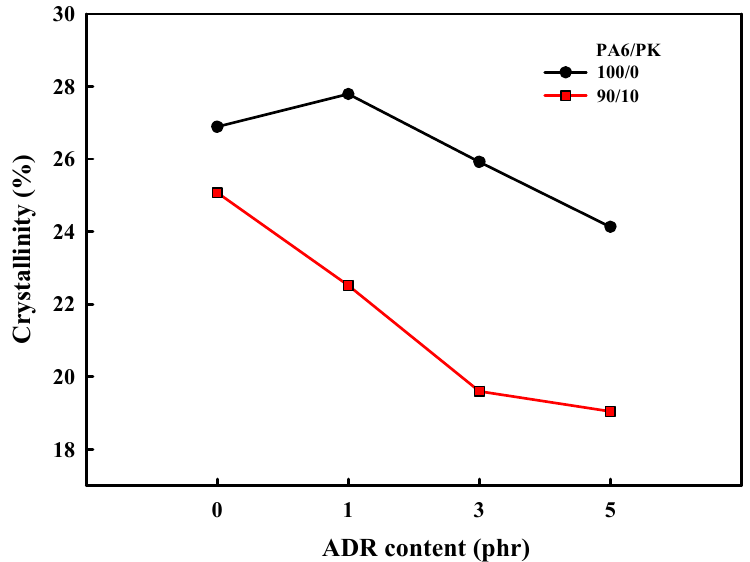
Figure 10. Effect of chain extender, ADR, content on the crystallinity of PA6 and PA6/PK blends with chain extender, reflecting the influence of chain branching.